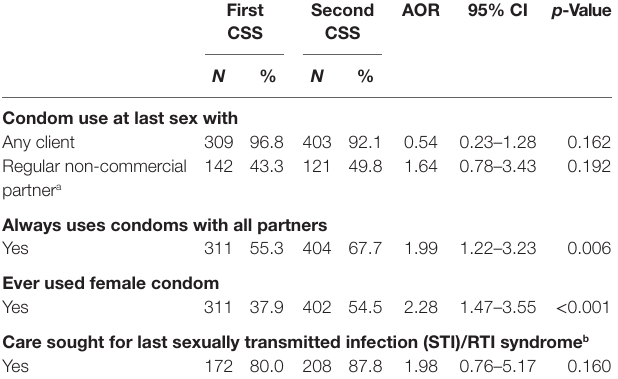
TaBle 2 | Characteristics of focus group discussion (FGD) participants. characteristics